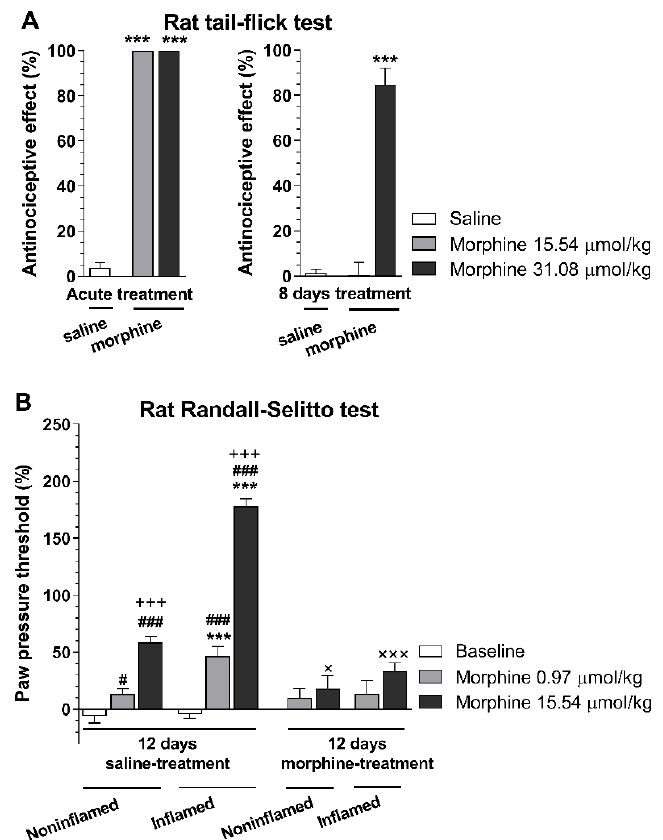
Figure 3. Analgesic effect of morphine in tolerant and non-tolerant rats in the rat tail-flick ( A ) and